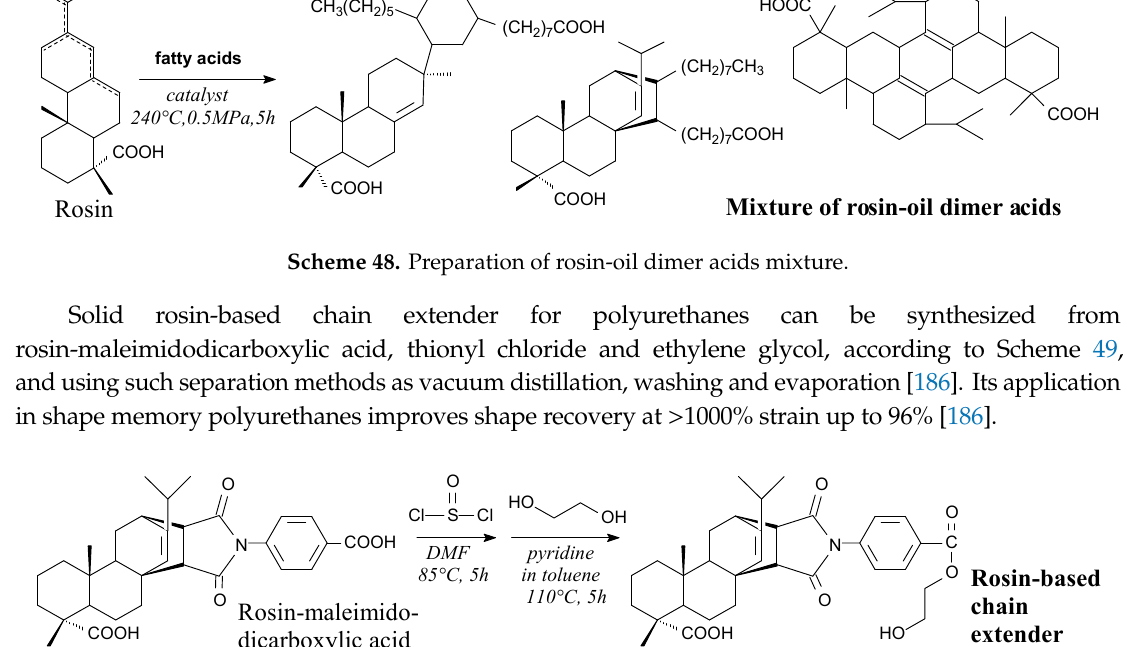
Scheme 49. Synthesis of rosin-based chain extender for polyurethanes.